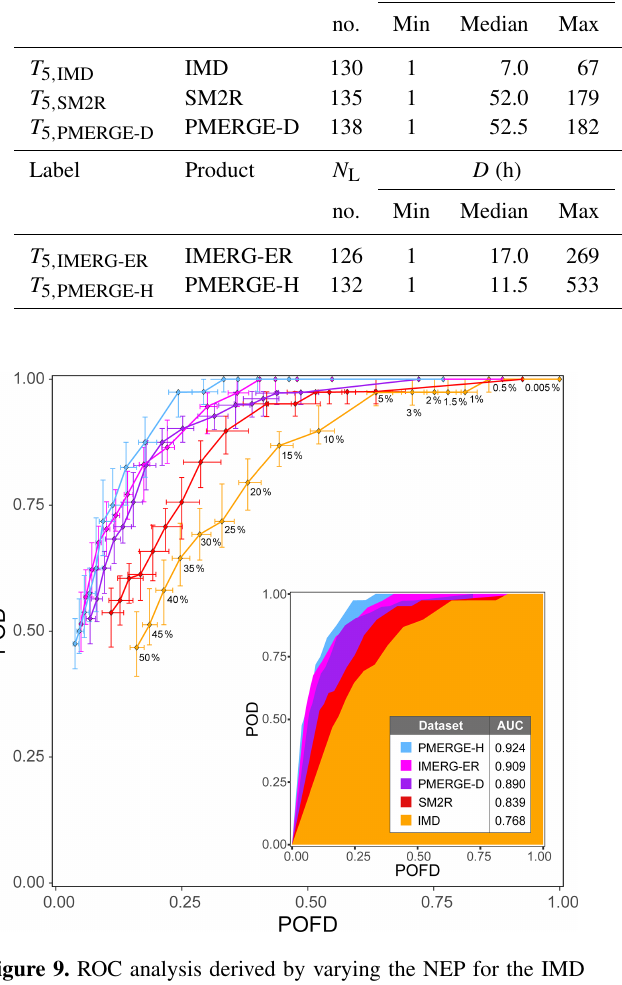
Figure 9. ROC analysis derived by varying the NEP for the IMD (orange), SM2R (red), PMERGE-D (purple), IMERG (magenta), and PMERGE-H (blue) datasets. Error bars depict the interval of variation of POFD and POD. Inset graph shows the AUC for each